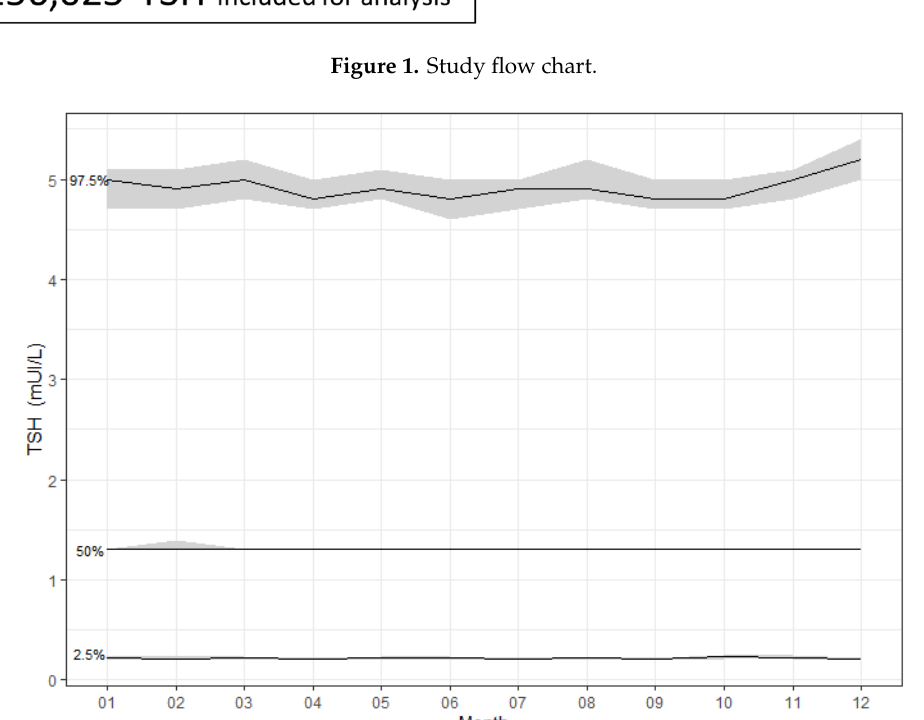
J. Clin. Med. 2020 , 9 , x